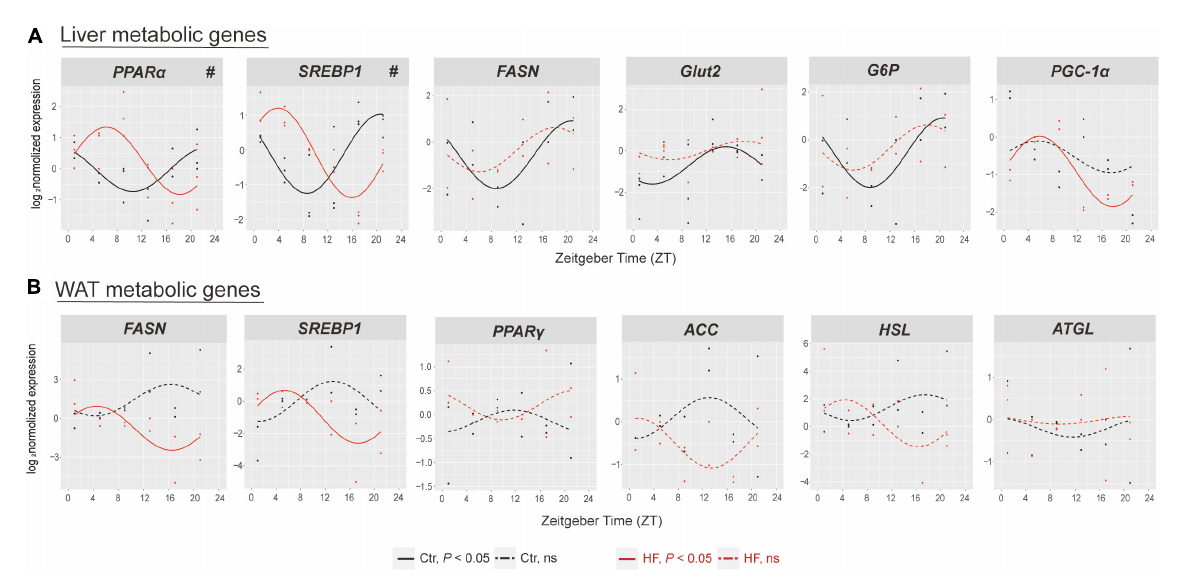
FIGURE3 The effects of high-fat diet on metabolic genes of liver and white adipose tissue in gestational mice. Mice were fed with a standard chow diet or a high-fat diet prior to pregnancy for 5 weeks, and throughout pregnancy. The morning of vaginal plug confirmed the pregnancy and was considered E0.5. On E18.5, the mice were killed at 4-h intervals over 24 h. Rhythmic pattern of metabolic genes in the (A) liver and (B) WAT. Significant rhythms ( P < 0.05) are denoted by the continuous line, and non-significant rhythms are denoted by the dotted line. The dots mark individual measurements in each zeitgeber time (ZT), and line represents cosinor regression fit. Rhythmic pattern of genes with significant differences in phase (#) derived from CircaCompare ( n = 2–3/time point). Ctr, standard chow diet-fed pregnant mice; HF, high-fat diet-fed pregnant mice; WAT, white adipose